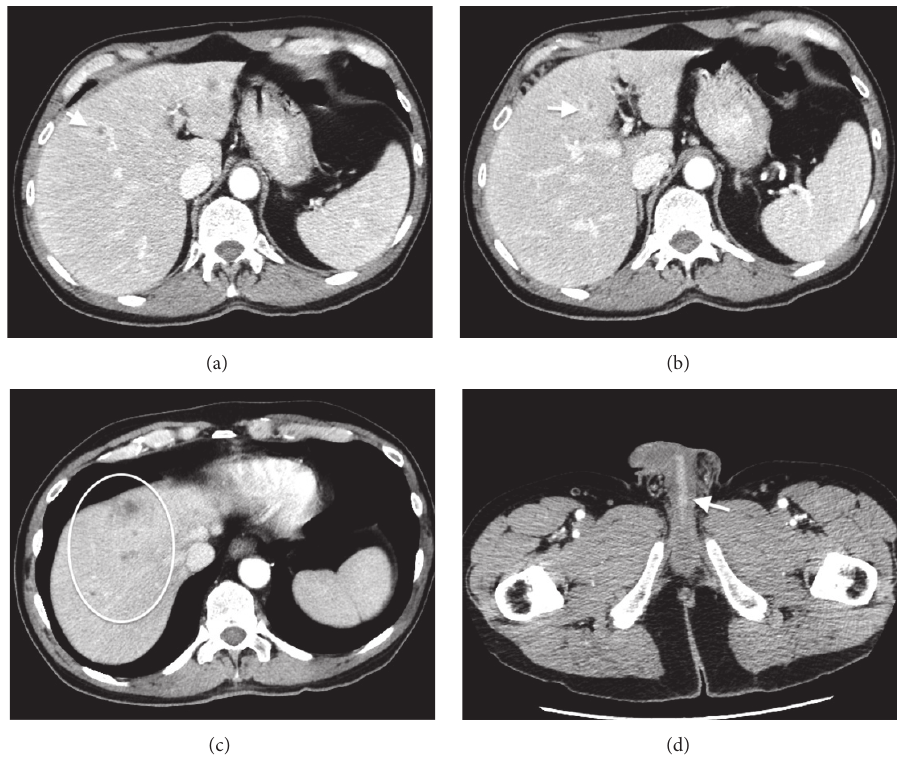
Figure 1: Four axial contrast-enhanced CT images of the abdomen and pelvis. ((a) and (b)) Several rim enhancing lesions are identified in the right and left hepatic lobes (arrows). (c) Nonenhancing hepatic lesions at the hepatic dome (circle); (d) axial image through the inferior pelvis with prominent enhancement along the urethra